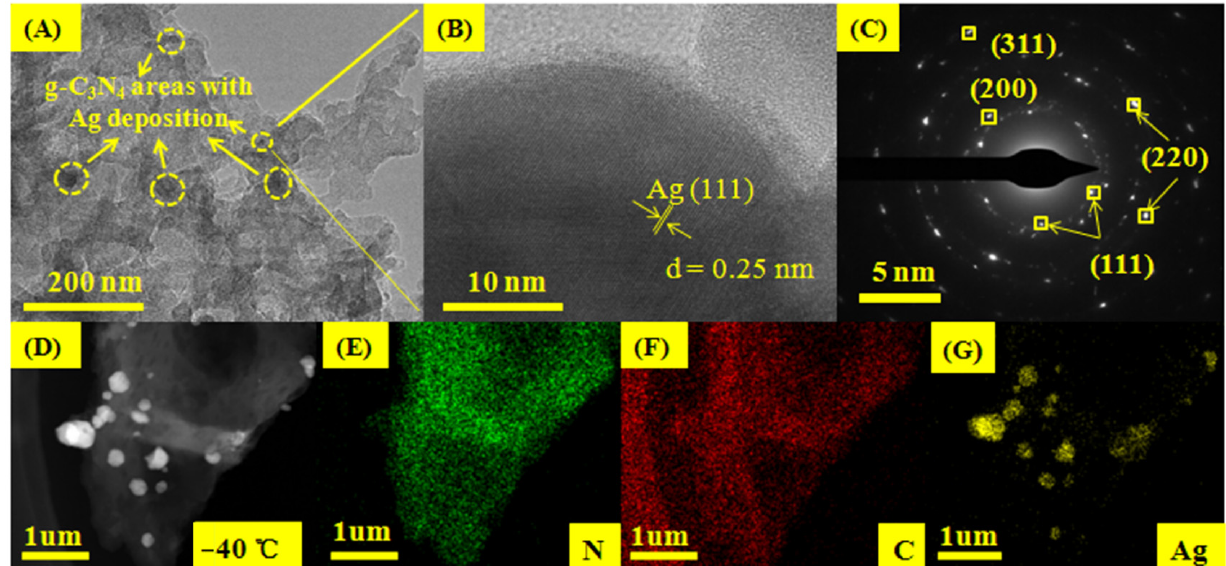
Figure 2. TEM images and its element distribution for Ag/C 3 N 4 ( − 40). ( A – C ) TEM images, ( D ) HAADF-STEM image, ( E – G ) element distribution of N, C, and Ag.